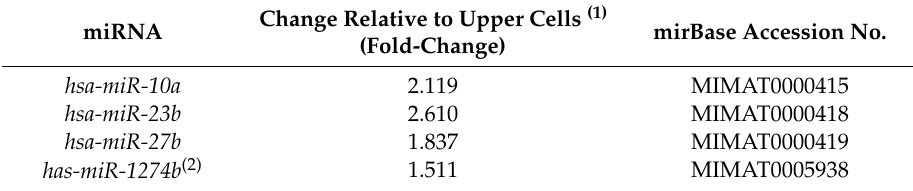
Table 1. MicroRNAs (miRNAs) with > 1.5-fold significant expression change in the migrated cells (MG